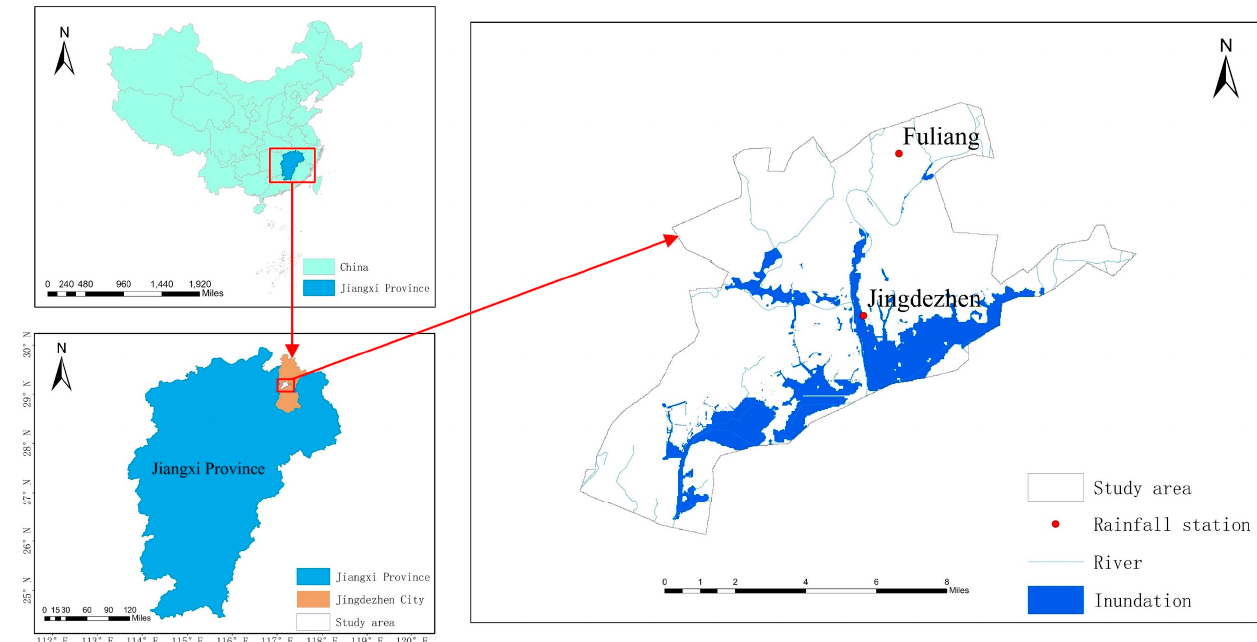
Figure 3. Jingdezhen City and 100-year return period inundation area.